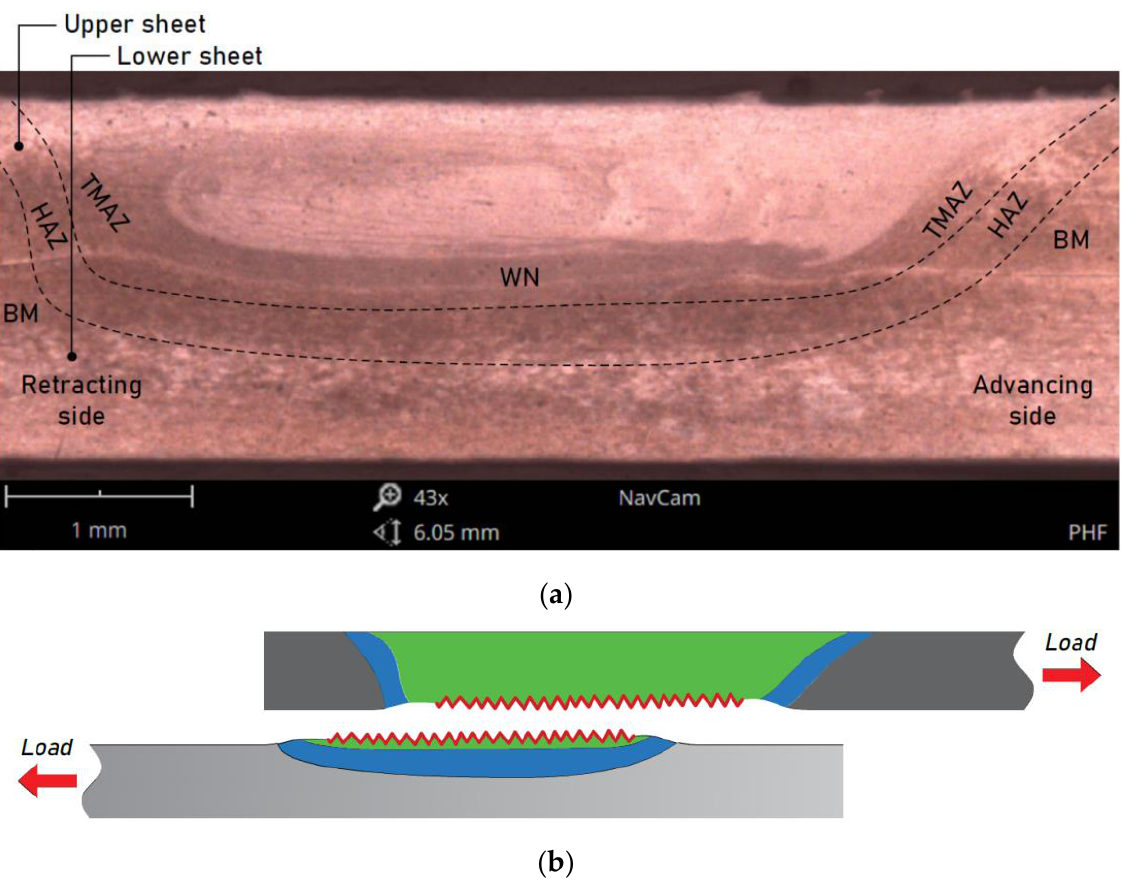
Figure 9. ( a ) Cross-sectional view of the FSW sample and ( b ) shear failure mode for a weld made with the parameters d = 1.1 mm, f = 400 mm/min, and n = 1600 rpm.